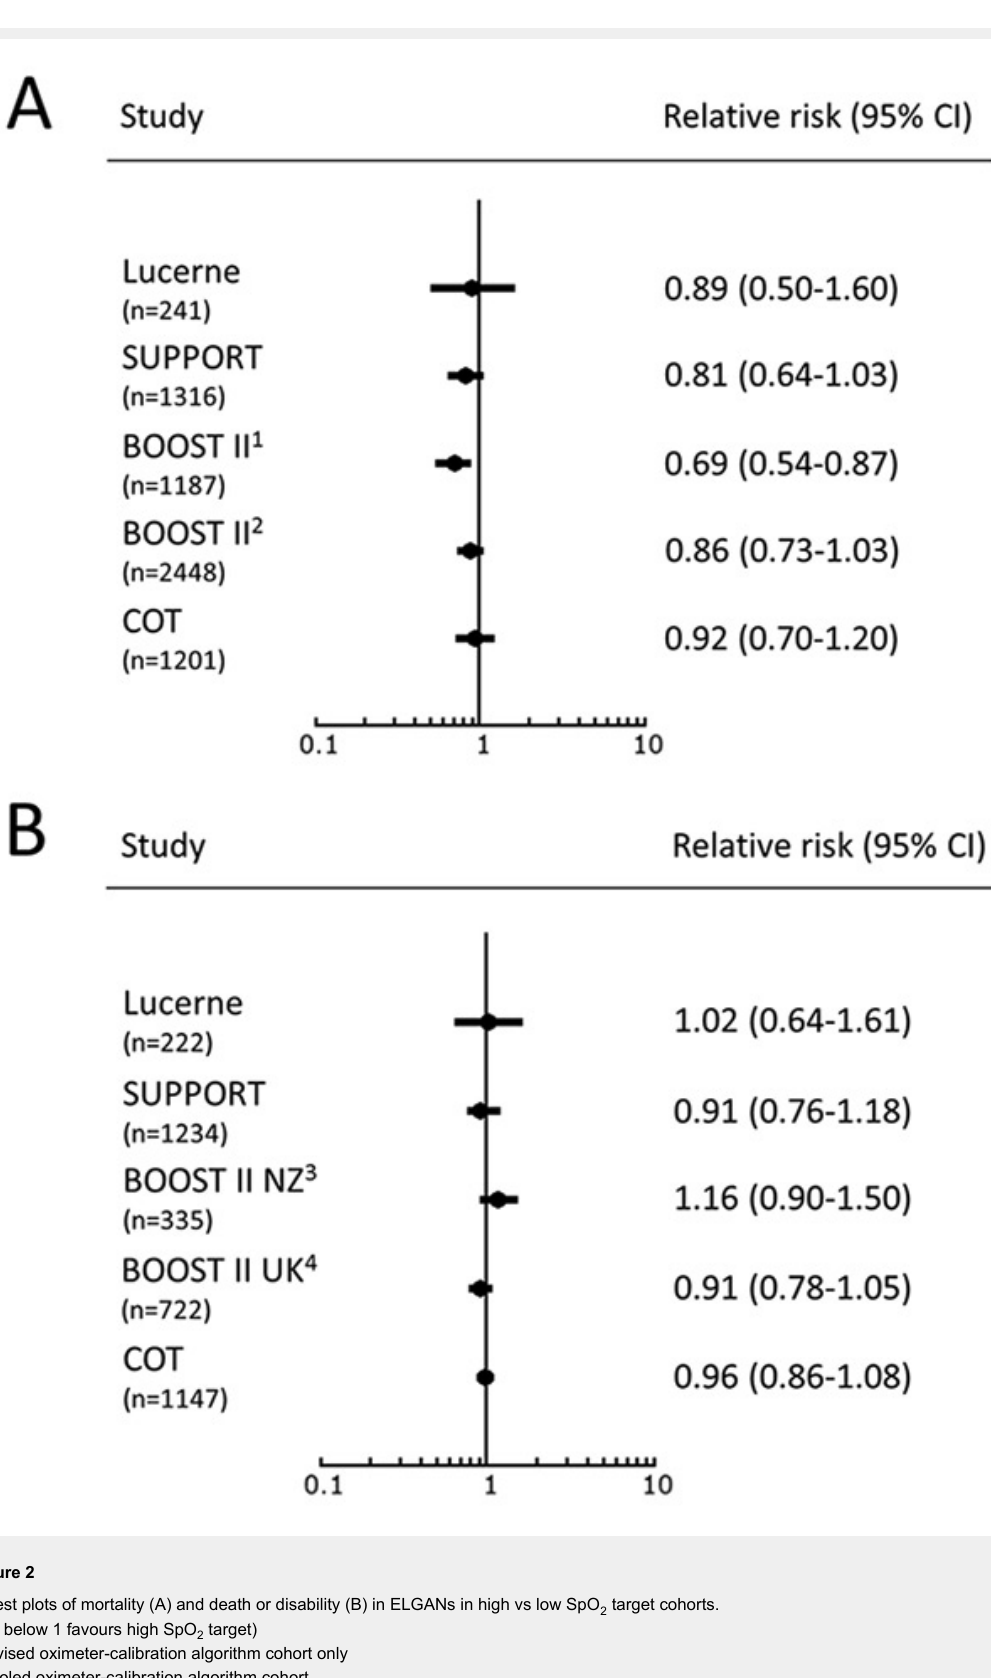
Figure 2 Forest plots of mortality (A) and death or disability (B) in ELGANs in high vs low SpO 2 target cohorts. (RR below 1 favours high SpO 2 target) 1 revised oximeter-calibration algorithm cohort only 2 pooled oximeter-calibration algorithm cohort 3 New Zealand cohort only 4 UK revised oximeter-calibration algorithm cohort only, preliminary data